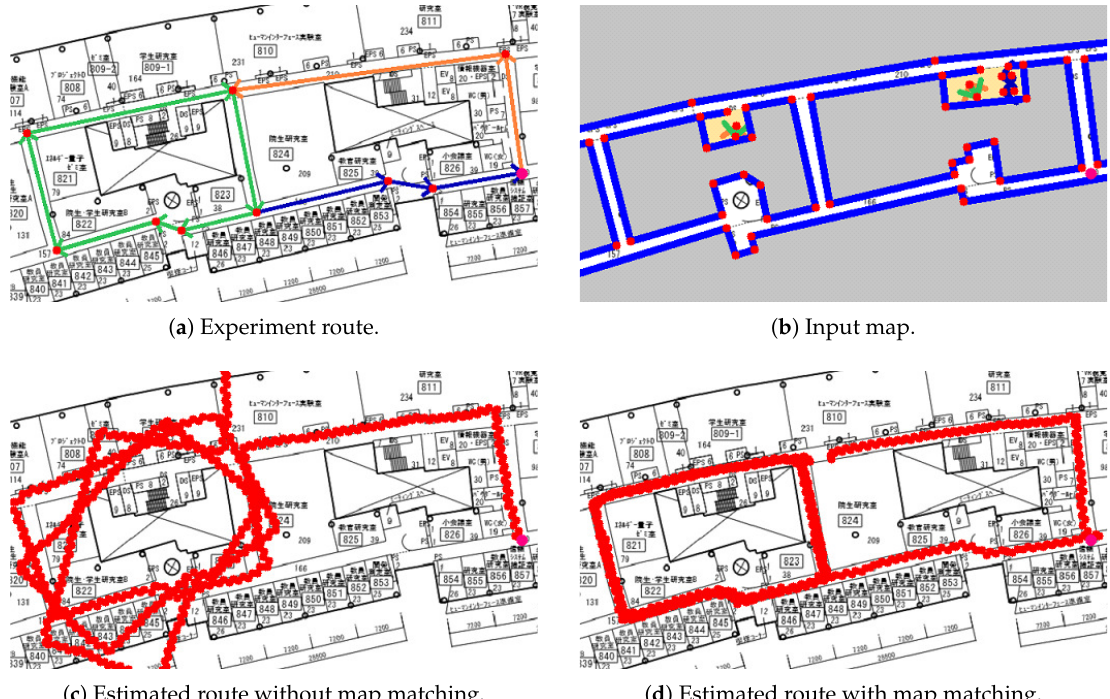
Figure 13. Experiment 1: system evaluation with different configurations.